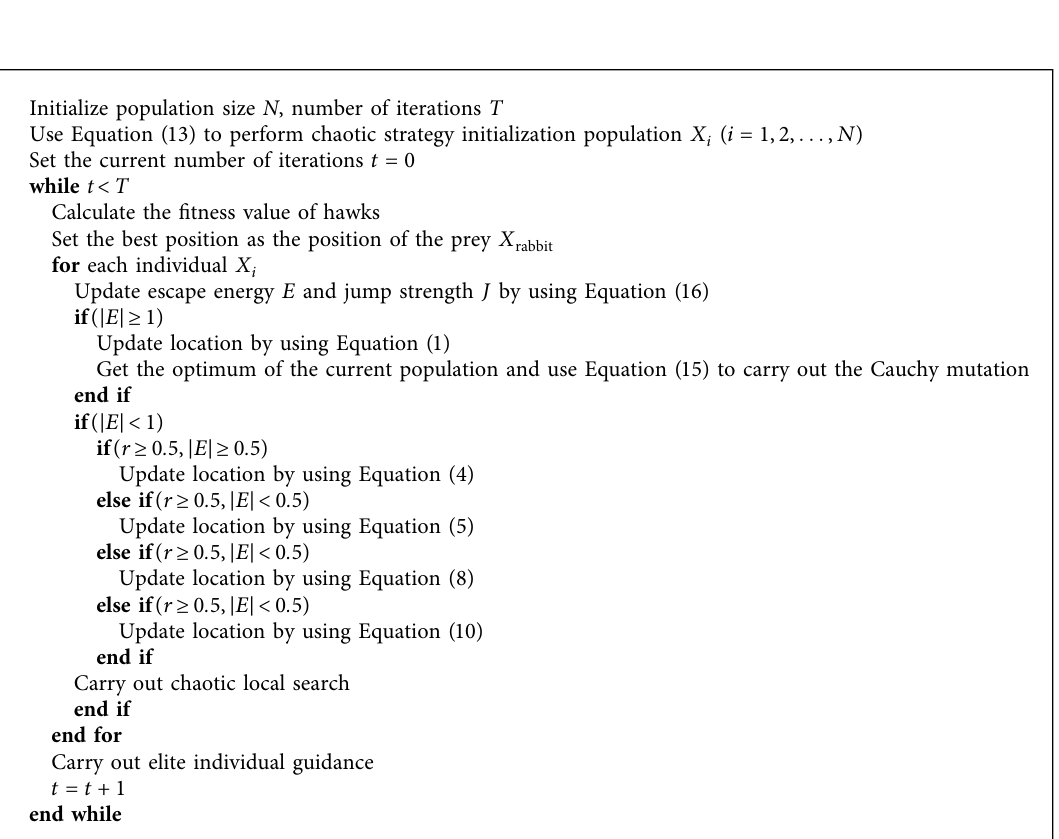
A LGORITHM 2: CCCHHO